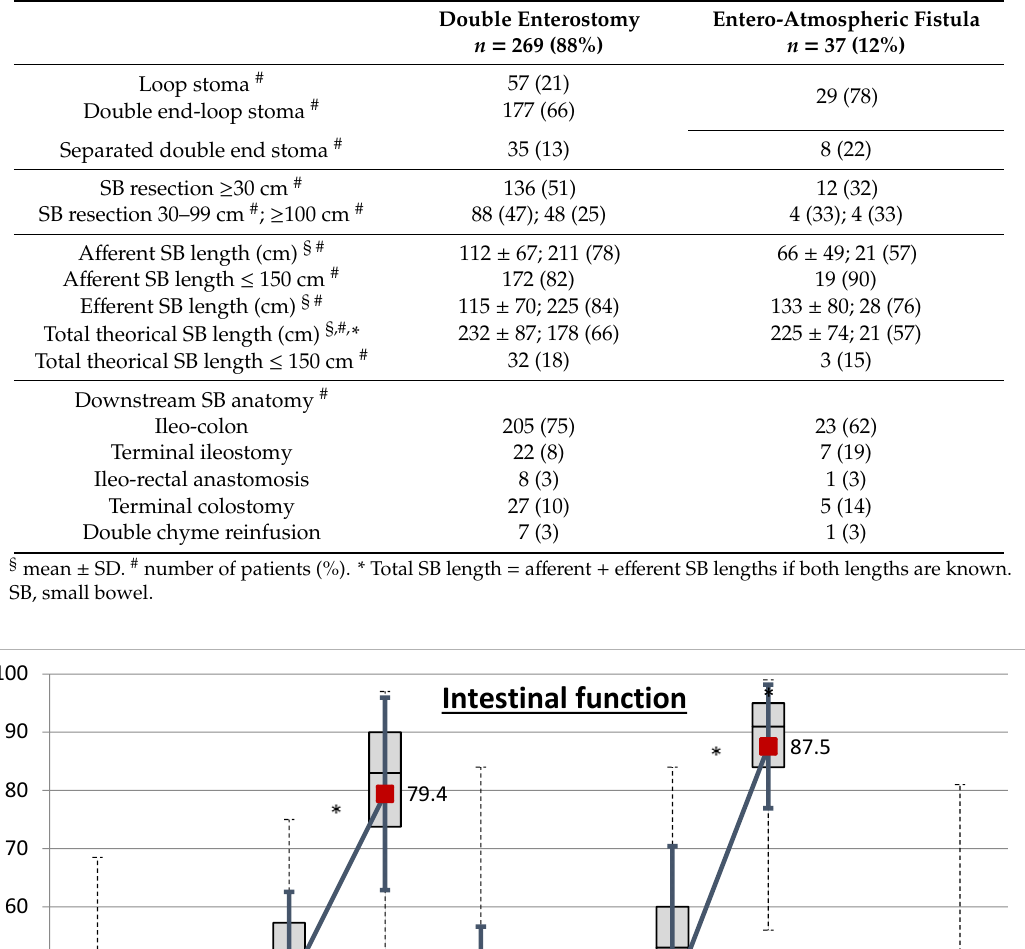
Table 2. Consequences of surgical procedures on the small bowel anatomy.